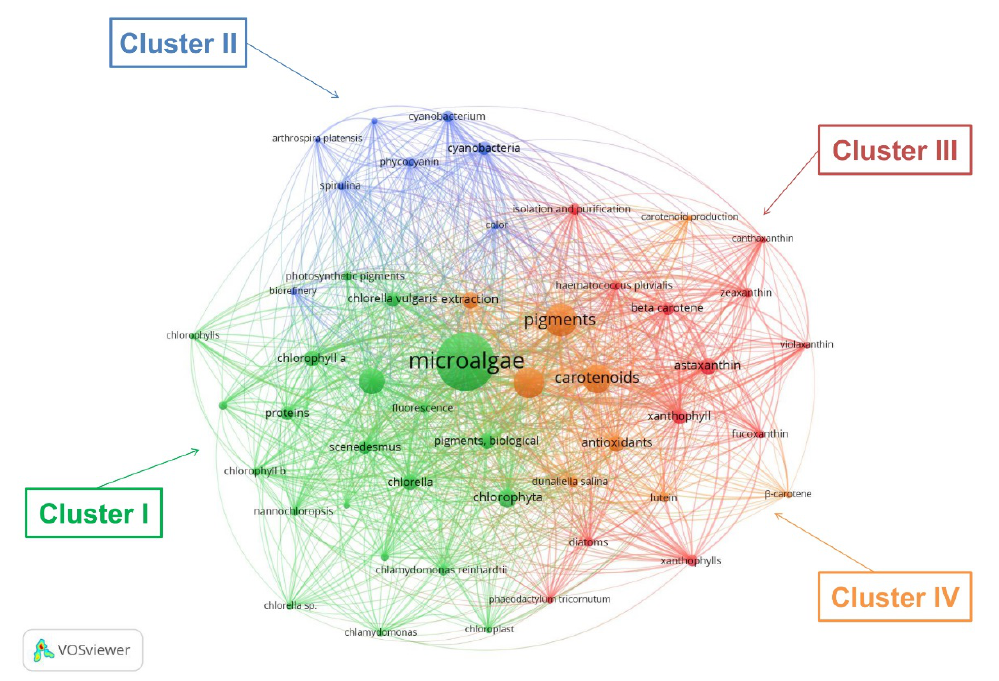
Figure 4. Keyword co-occurrence network analysis and emerging clusters ( Cluster I : 21 words “ Chlorophylls from Chlorella vulgaris ”; Cluster II : 8 words “Phycocyanin from Spirulina platensis ”; Cluster III : 12 words “Astaxanthin from Haematococcus pluvialis ”; Cluster IV : 9 words “ β -carotene from Dunaliella salina ”). Table 2. Clusters and words obtained from keyword co-occurrence network analysis.